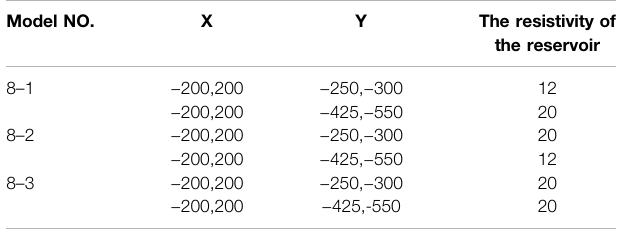
models of hydrate reservoirs that need to be compared in this group. Model NO.